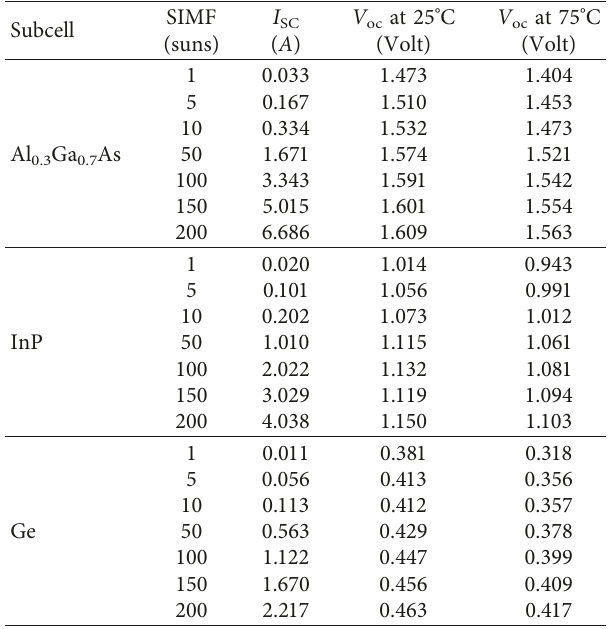
Table 3: The I-V performances of each subcell at various SIMFs at the temperatures of 25 ° C and 75 ° C. SIMF Subcell